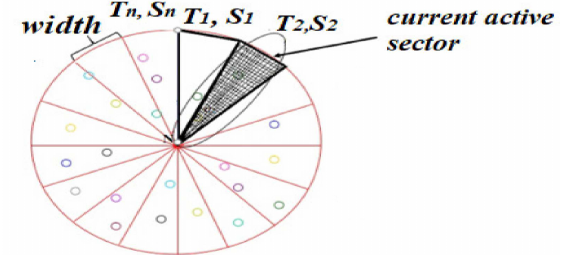
Figure 1. Round-robin MAC